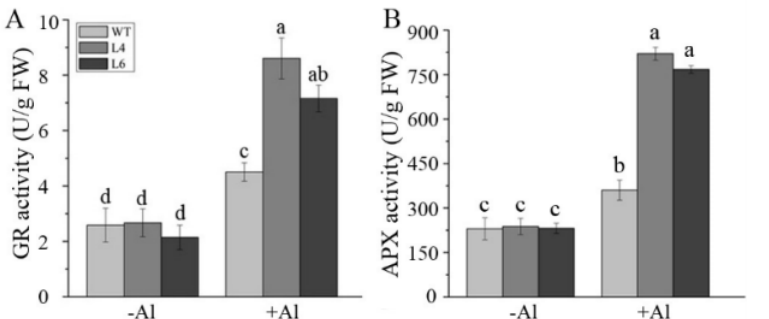
Figure 9. Activity of GR and APX in wild–type and transgenic plants. The activity of ( A ) GR and ( B ) APXin wild–type plants and transgenic lines after exposure to Al for 12 h. Values are means ± SD ( n = 20). Different letters indicate significant differences ( p < 0.01) (Tukey’s